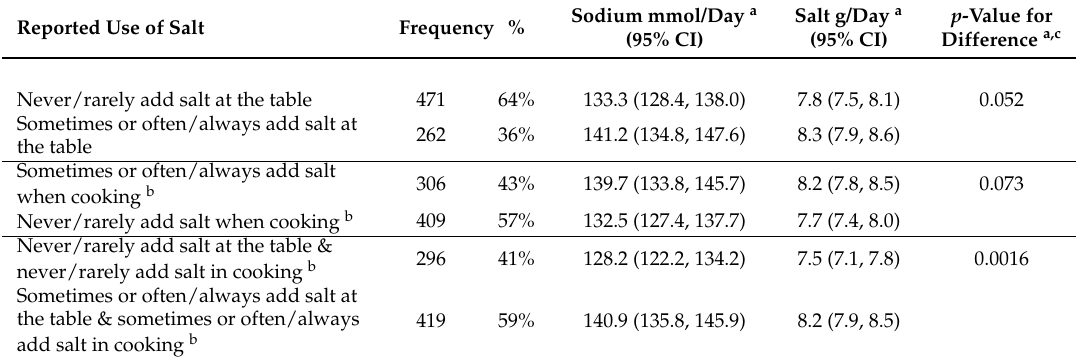
Table 2. Comparison of 24 h sodium and salt excretion (mean (95% CI) by frequency of use salt in cooking and at the table for individuals participating in both surveys ( n =